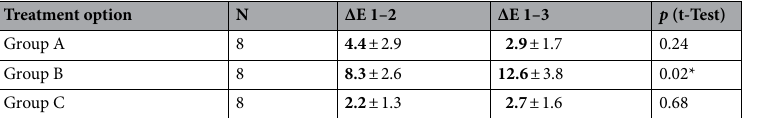
Table 2. Mean color differences and standard deviations of treatment groups between the application of the surface treatment and the subsequent readings. Ref. ∆E: Color difference— *significant differences.